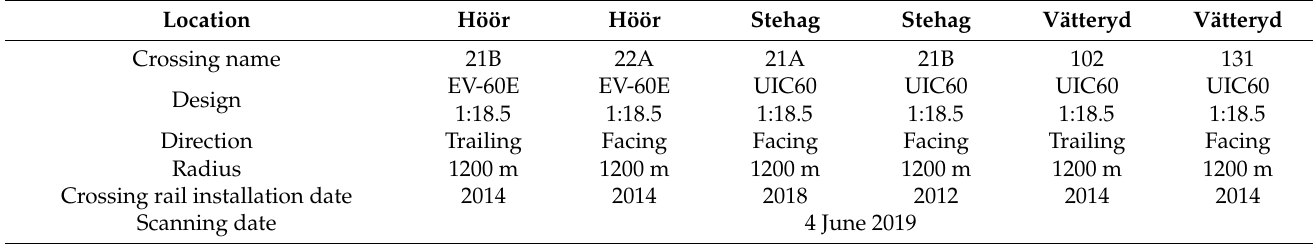
Table 1. Crossing panel data.